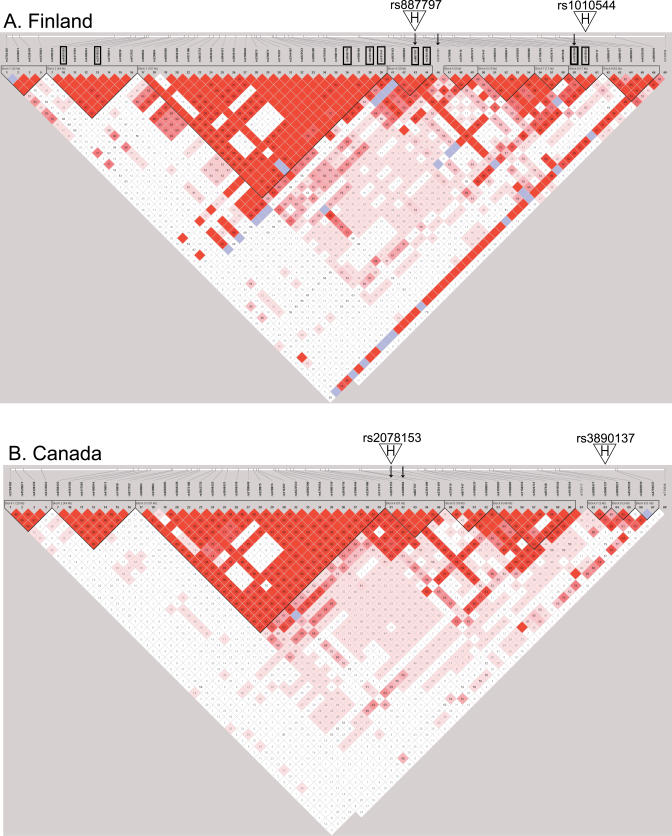
Haplotype Block Structure of the PRKCA Gene in Finnish and Canadian Populations(A) shows the block structures of the PRKCA gene (between SNPs rs3764402 and rs4791037) in 211 Finnish MS families; (B), in the 554 Canadian MS families. The haplotype blocks were created using the solid line of LD of the Haploview program, version 3.2 [27]. The SNPs providing strongest evidence for association to MS in PRKCA in Finns and Canadians (rs887797, rs2361491 and rs2078153, rs1860984, respectively) are marked with black arrows, SNPs used in Haploview version 3.2 [27] haplotype analysis in 211 Finnish families are indicated with boxes, and those used in the two SNP genotype combinations are indicated with a white arrowhead with the letter H and the rs-numbers given above.